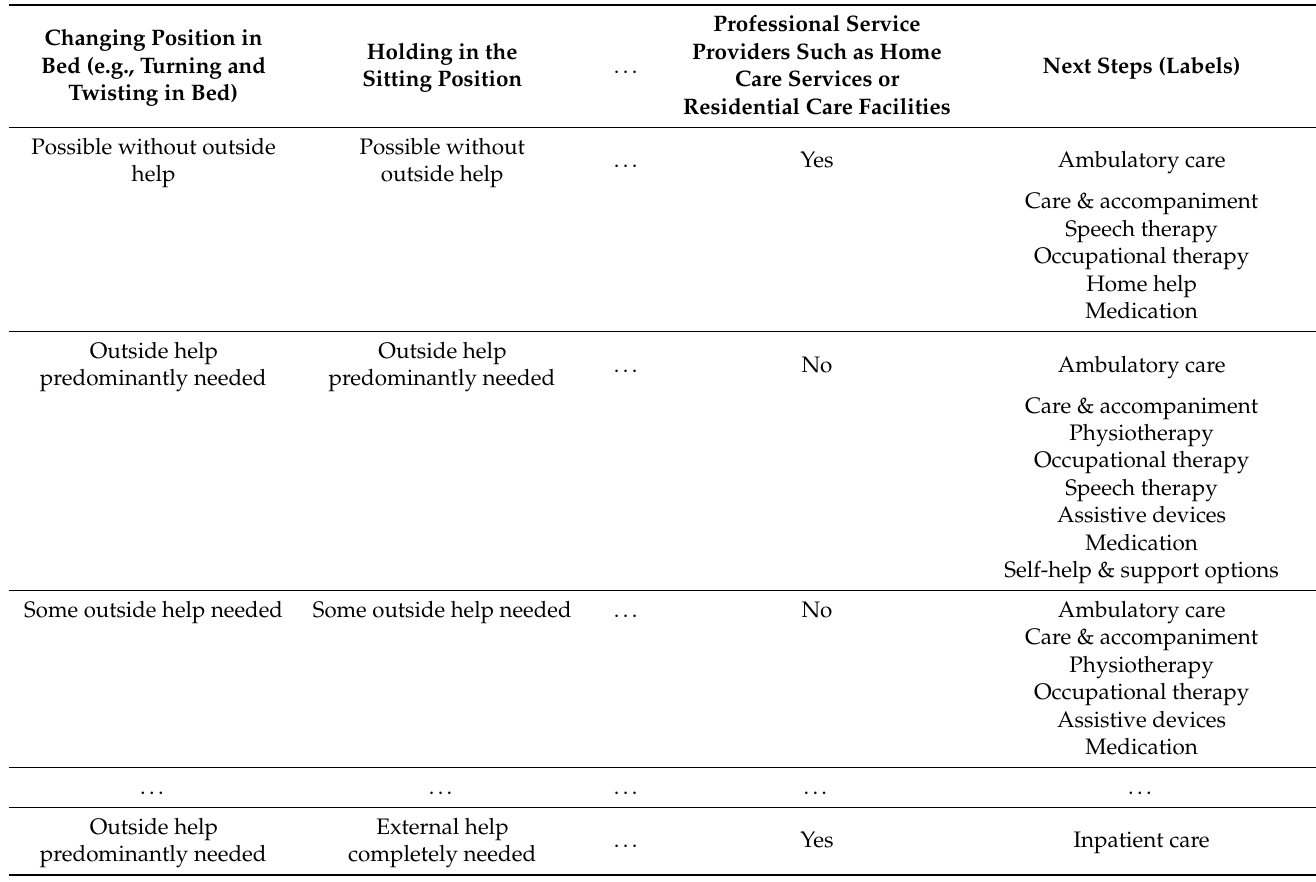
Table 1. Structure of the generated